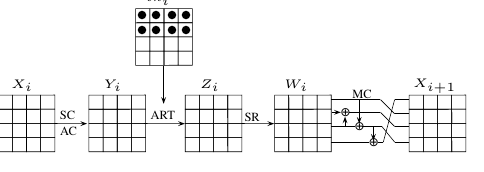
Figure 2: i th round of SKINNY. Only the first two rows (cells marked with ) in the round tweakey tk i are xor’ed in each